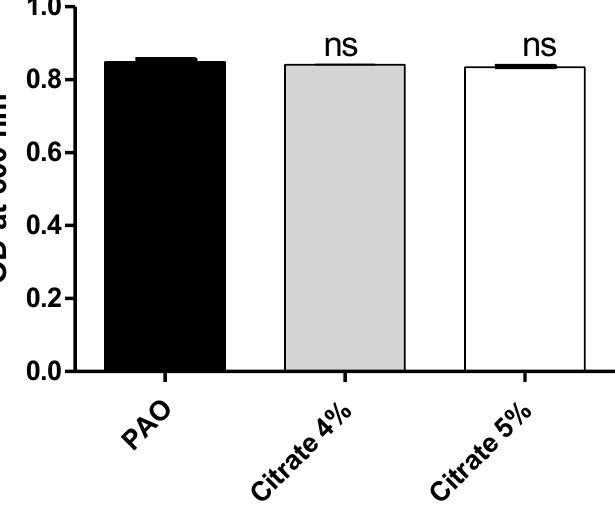
Figure 1. Sodium citrate does not affect P. aeruginosa growth. The optical densities of P. aeruginosa growth were measured at OD 600 after 24 h incubation in the presence and absence of 4% or 5% sodium citrate. ns: non-significant.